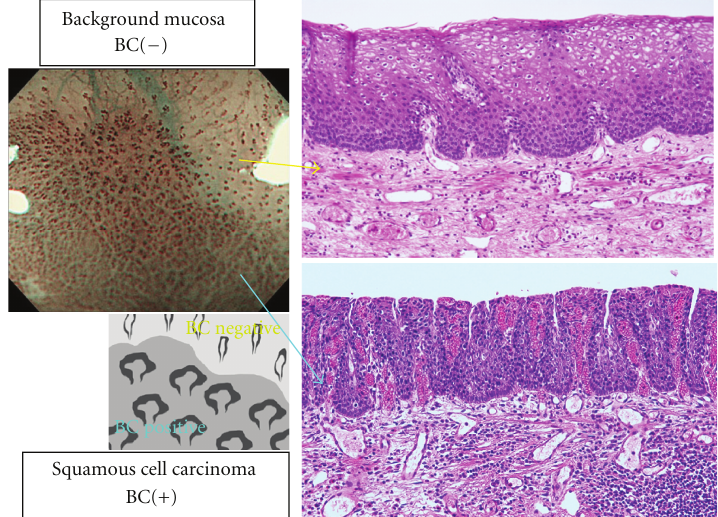
Figure 4: To evaluate the pathological di ff erence between background mucosa (BC negative) and cancerous area (BC positive), we compared two lesions that were positive for BC and negative for it. See the di ff erences in number of cells, N/C ratio, state of keratosis, level of inflammatory cells